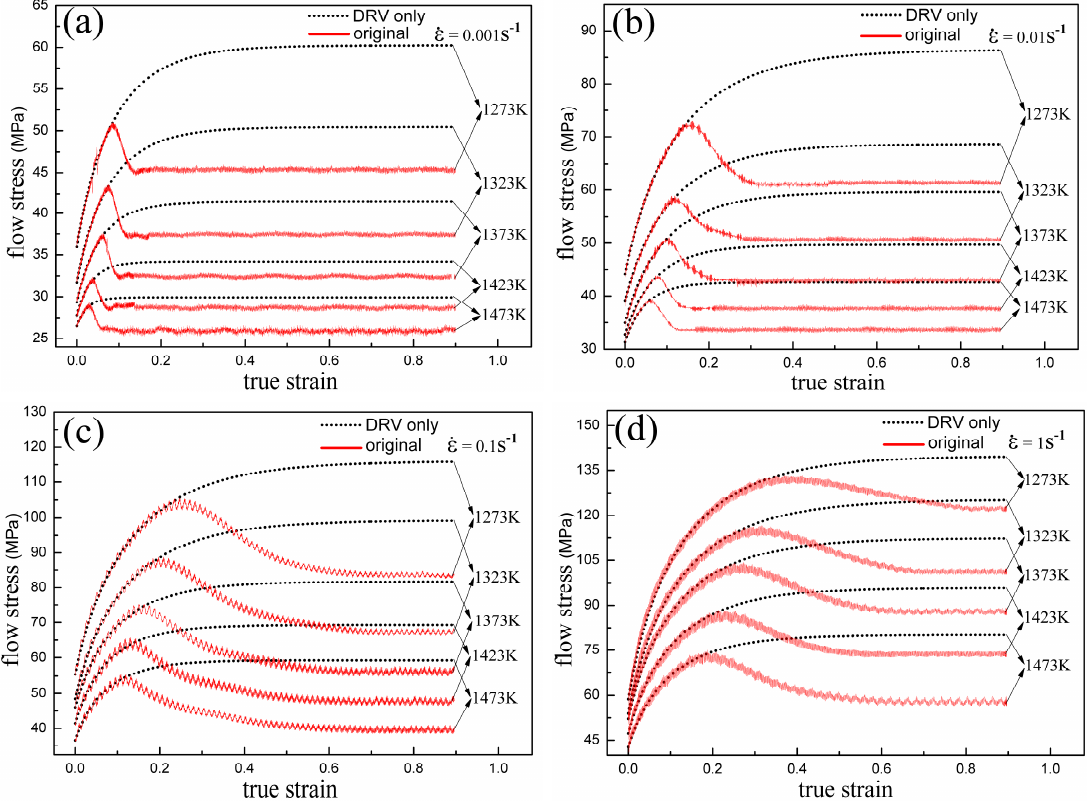
Figure 4. Original true stress-strain curves and calculated flow stress curves considering only the DRV process of Armco-type pure iron: ( a ) red solid curves are the original true stress-strain curves while the dot lines are the curves calculated through Equation (8). The dot lines describe the work-hardening behavior of part I and the un-recrystallized regions in part II.